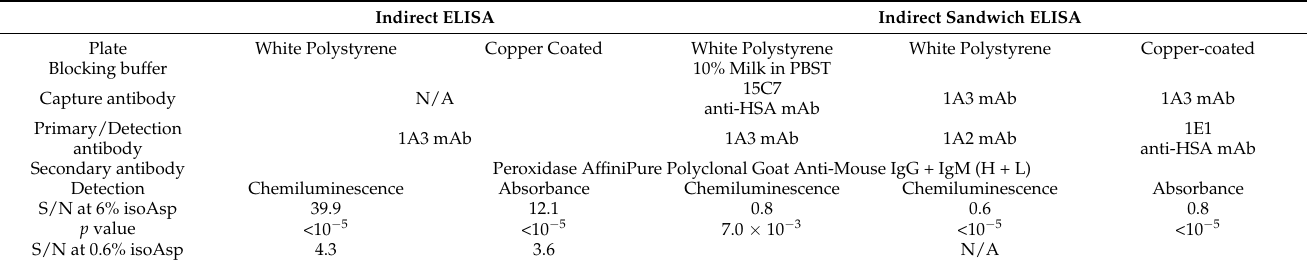
Table 1. Kinetic binding parameters of the interaction of 1A3 with